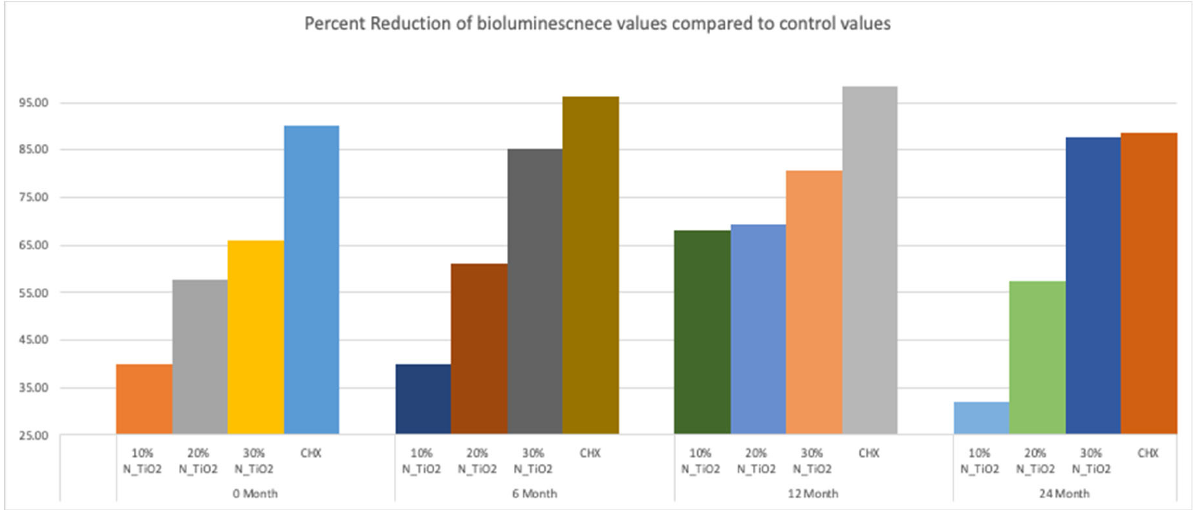
Figure 6. Percent reduction of bioluminescence values of experimental adhesive resins that were fabricated with aged adhesive resins, when compared to unaltered OPTB. Biofilms grown on specimens with higher concentrations of nanoparticles showed greater decrease in bioluminescence. CHX serves as a well ‐ established positive control.